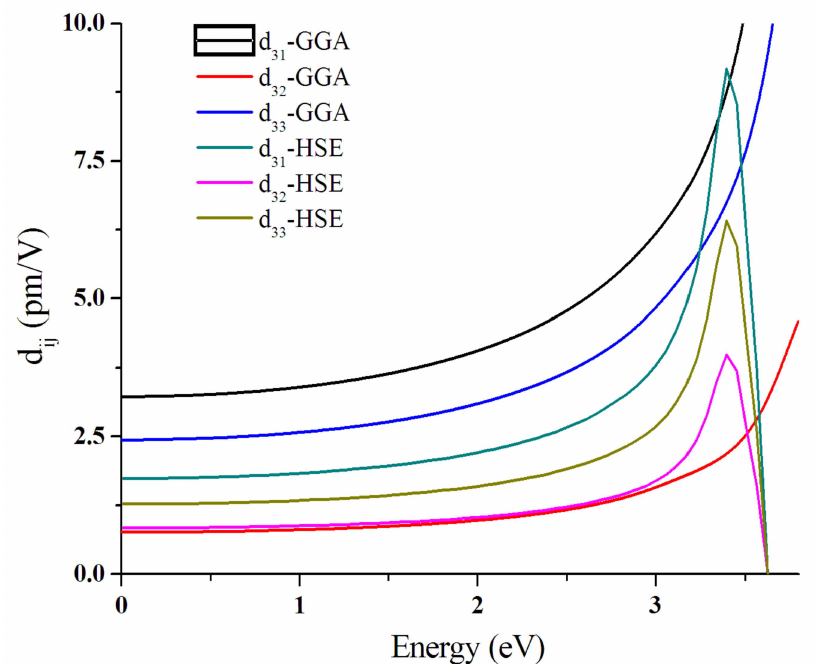
Figure 6. Calculated frequency-dependent second harmonic generation coefficients for Rb 2 Na(NO 3 ) 3 by generalized gradient approximation (GGA) and Heyd–Scuseria–Ernzerhof (HSE)